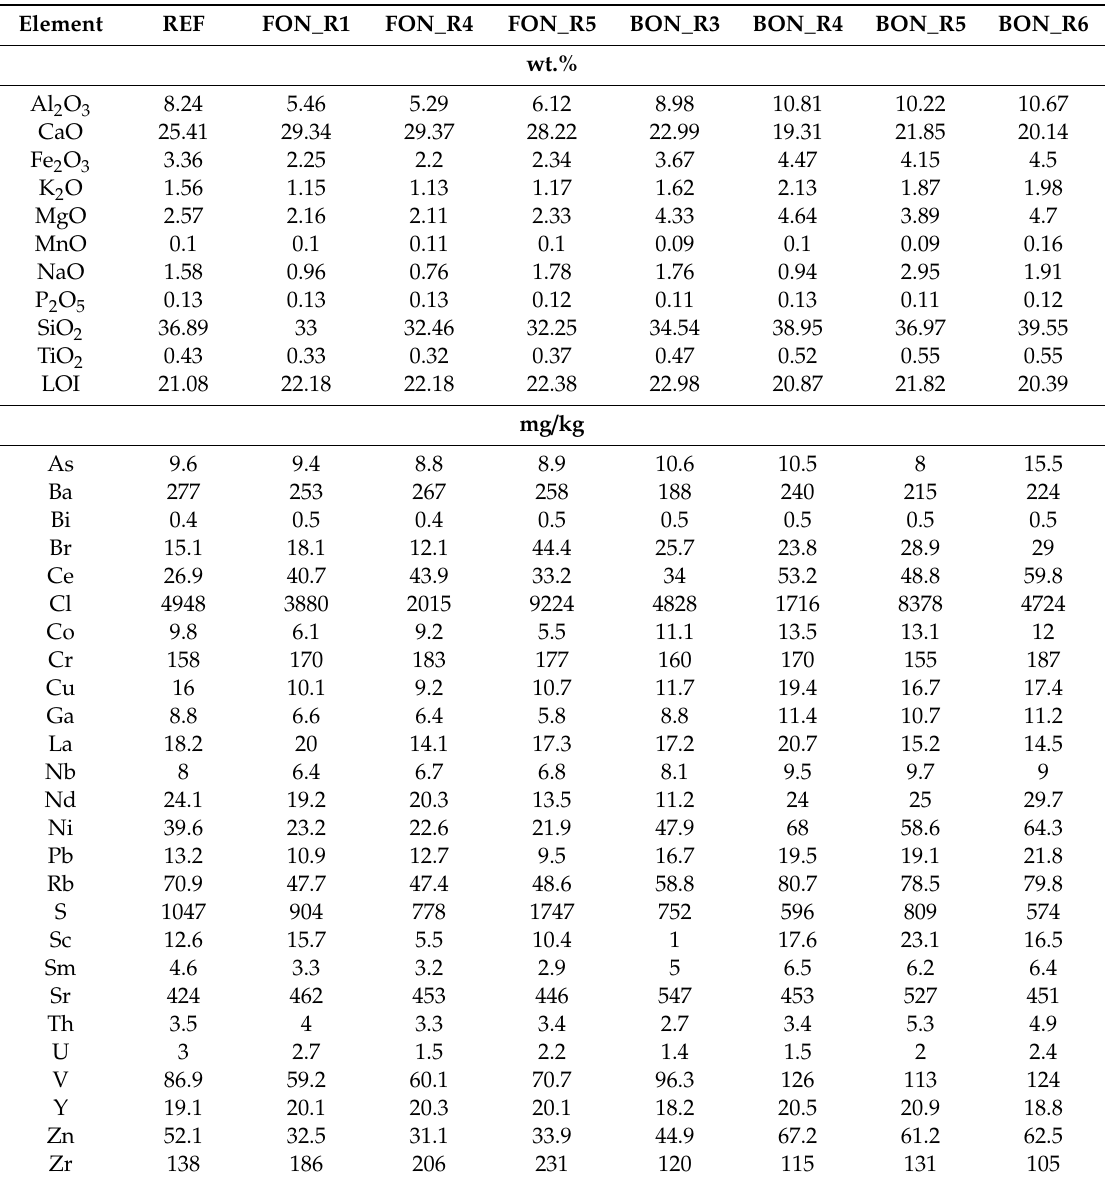
Table 5. Major and trace elements of the sediment samples collected at Fontespina and Bonaccia sites (FON, BON). REF stands for reference site representing the average conditions of the Central Adriatic sediments in use for both